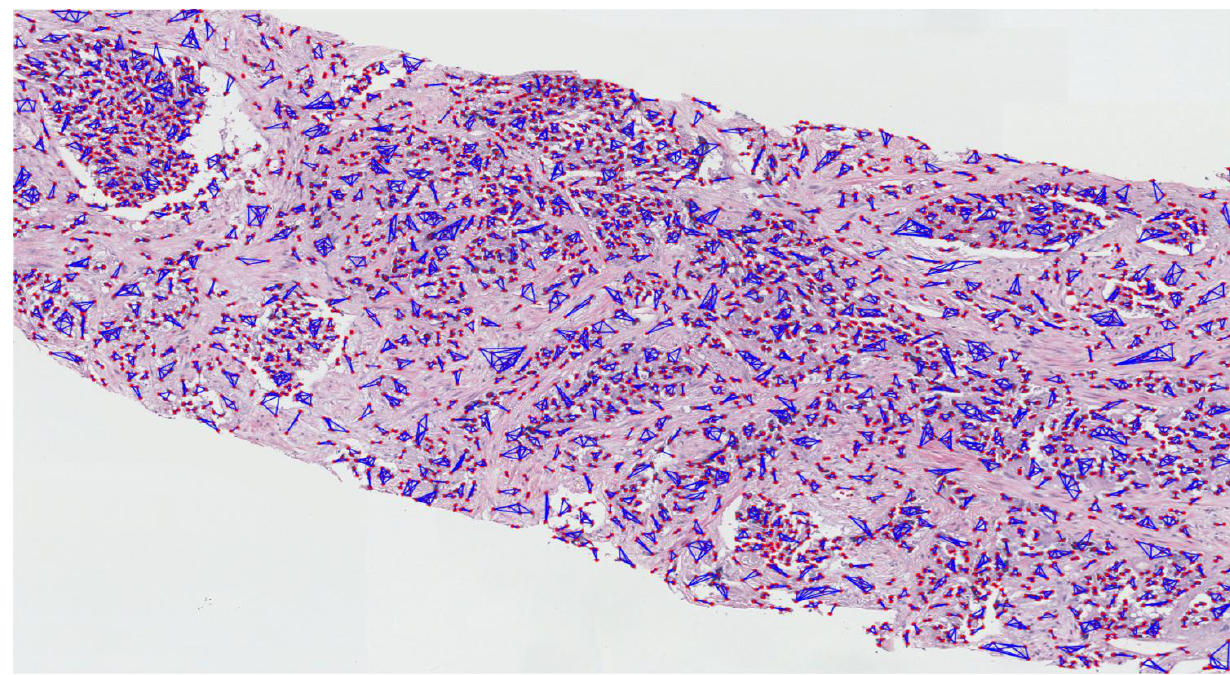
Figure A6. The proliferation and community structure of cell nuclei in the annotated region of grade 5.